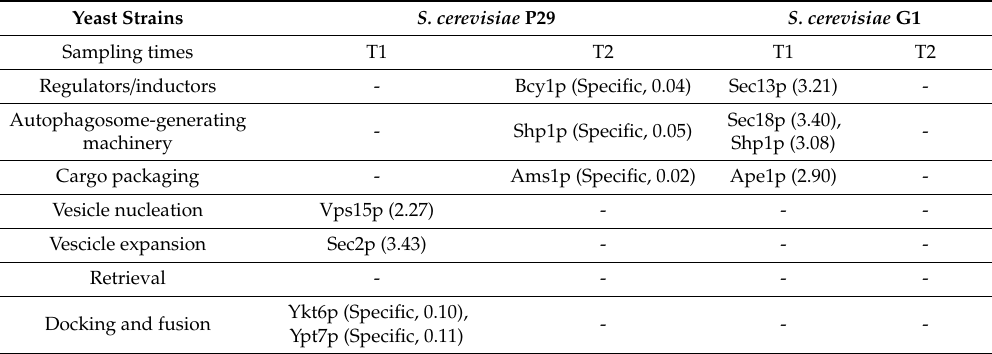
Figure 4. Protein content increases (mol%) under PC (pressure condition) of autophagy-related proteins compared to NPC (non-pressure condition). ( A ) protein content increases identified in S. cerevisiae P29. ( B ) protein content increases identified in S. cerevisiae G1. T1 (middle of the second fermentation), T2 (one month after the second fermentation). Table 2. List of over-represented autophagy-related proteins under PC (pressure condition) detected at the middle of the second fermentation (T1) and one month after it (T2), in both yeast strains ( S. cerevisiae P29 and G1). Proteins specifically found under PC and fold changes of the protein content PC/NPC are shown in brackets.